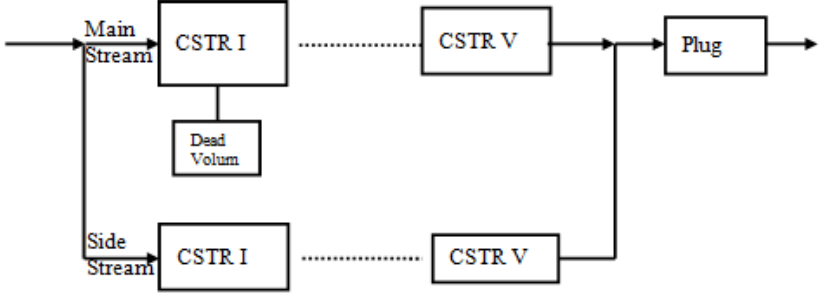
Figure 46. Proposed reactor arrangement for the cavity in the works of Daggupati et al. [90].